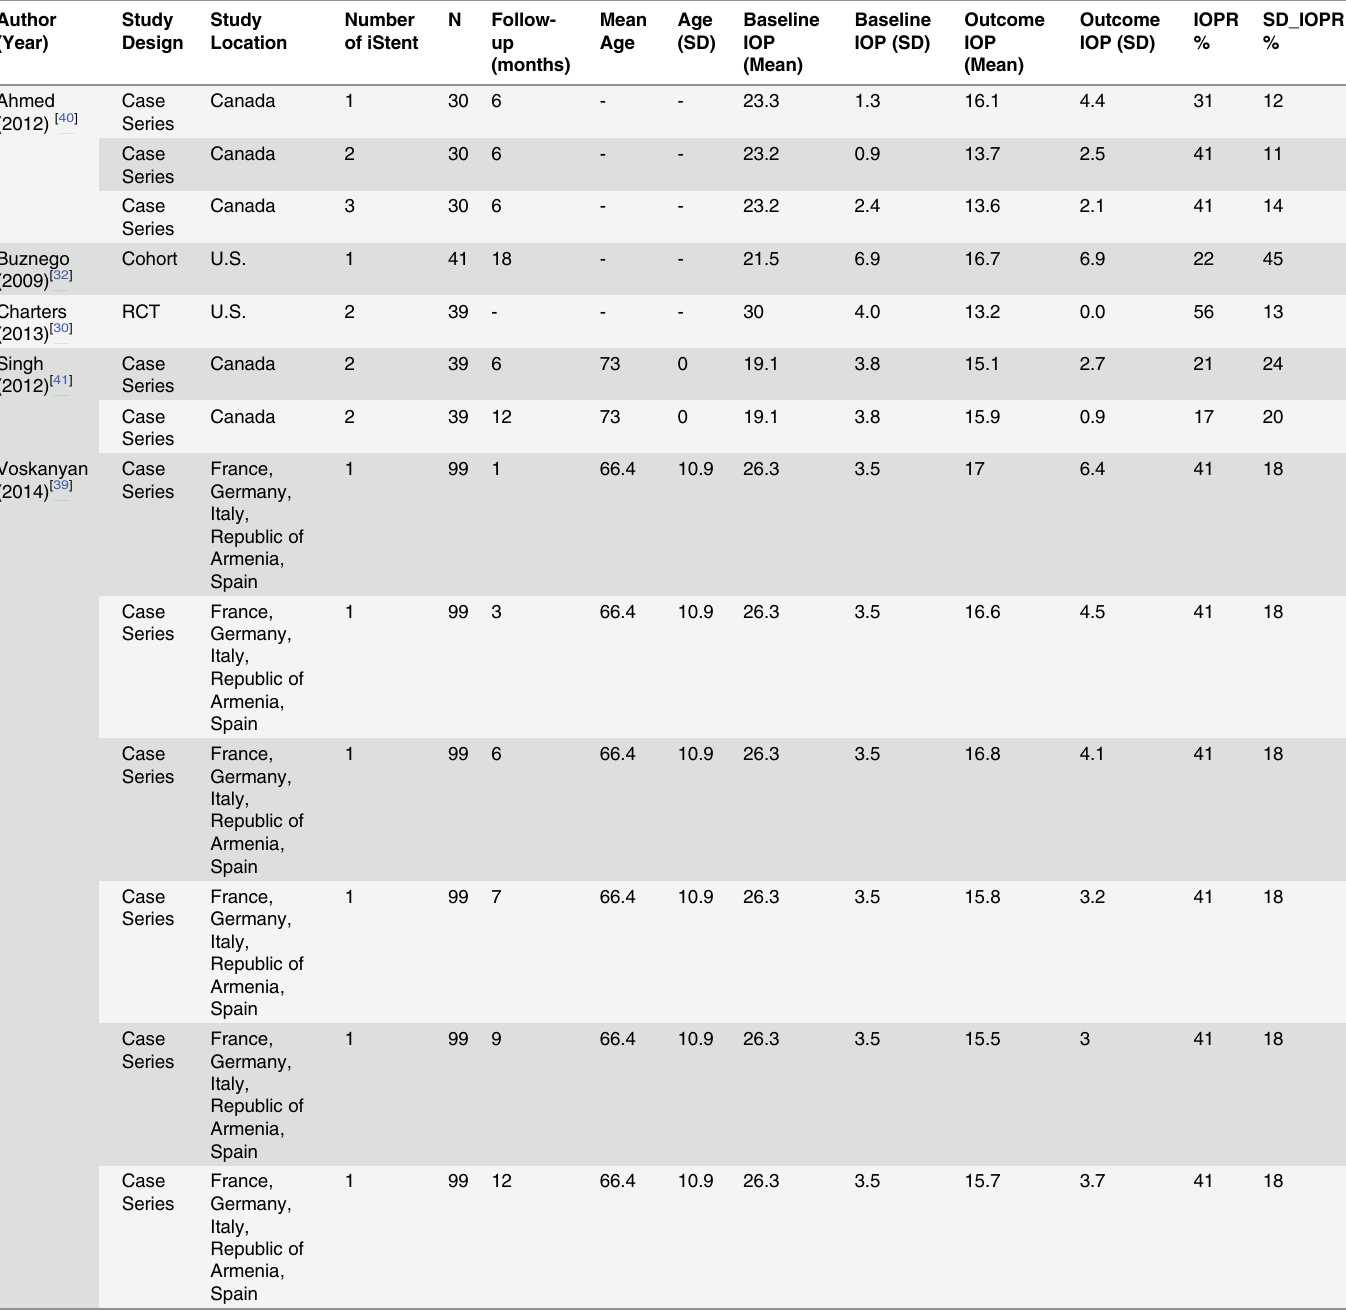
Table 1. Reported pre- and post-operative intraocular pressure in studies included in